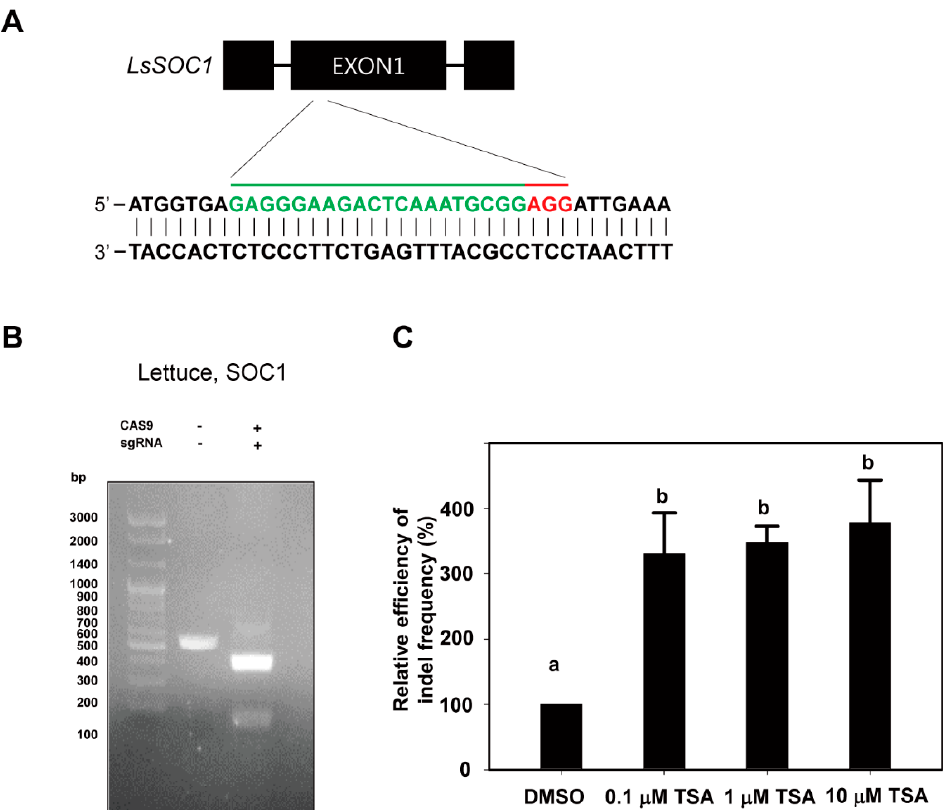
Figure 1. Changes in indel frequency according to TSA treatment in lettuce protoplasts. ( A ) Schematic illustration of the LsSOC1 CRISPR/Cas9 target site. The target region is shown in green letters followed by PAM (NGG; red). ( B ) In vitro DNA cleavage assay using LsSOC1 gRNA and Cas9 protein. The gRNA-mediated cleavage of target DNA in vitro is shown in agarose gel. The 546bp PCR fragment of the LsSOC1 gene is used as a substrate for gRNA-Cas9 digestion. LsSOC1 gRNA leads to a specific digestion of the target DNA, producing DNA fragments of 386 bp and 160 bp. ( C ) Relative efficiency of indel frequency (%) of at target site in protoplasts examined at 48 h after transfection of Cas9 and gRNAs as RNP complexes with DMSO or TSA treatment. The indel frequency of the DMSO treatment group was set to 100%, and those of the TSA treatment groups are shown relatively. Bars represent means ± SE ( n = 3) of independent experiments. Different letters on the bars indicate significant differences between each treatment (ANOVA with the Duncan’s test, p < 0.05).